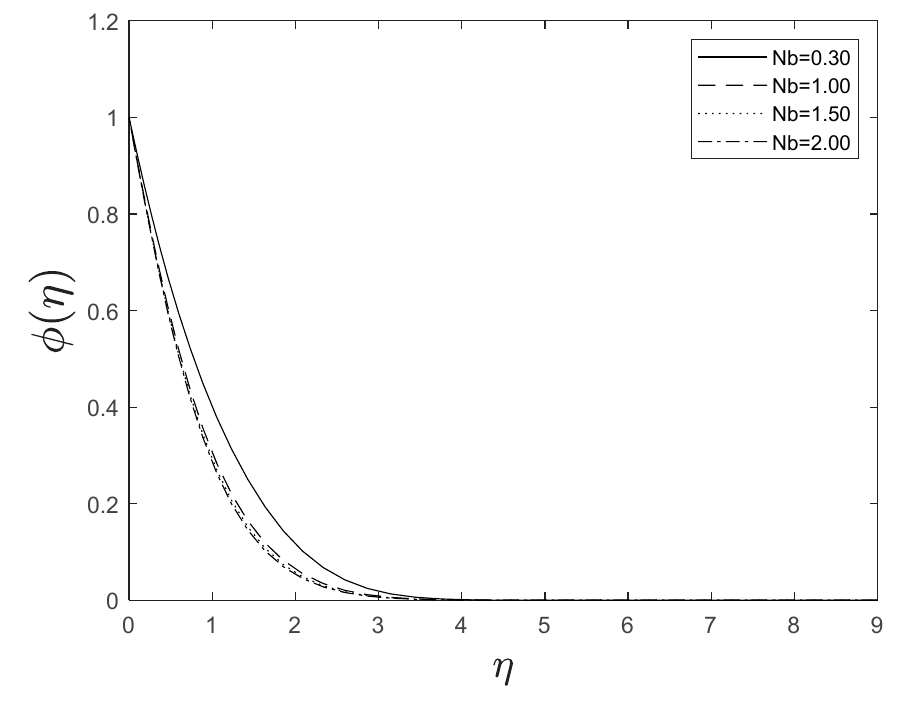
Figure 12. Effect of different values of Nb on φ ( η ) .